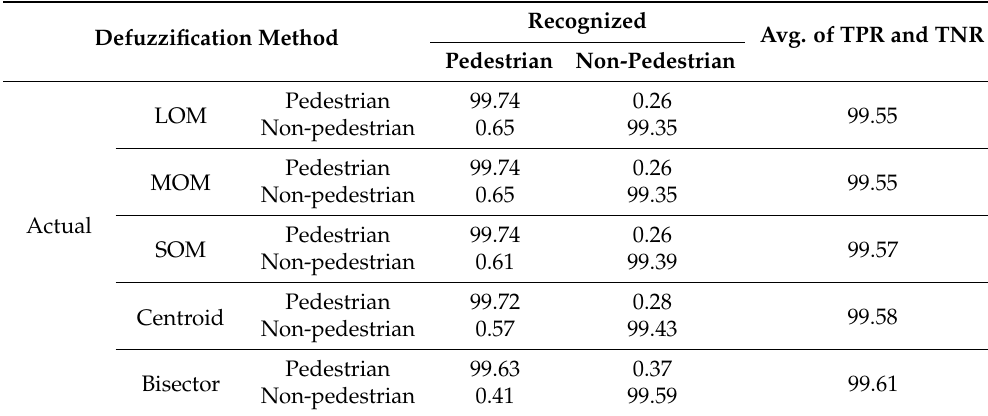
Table 7. Classification accuracies for defuzzification method (unit: